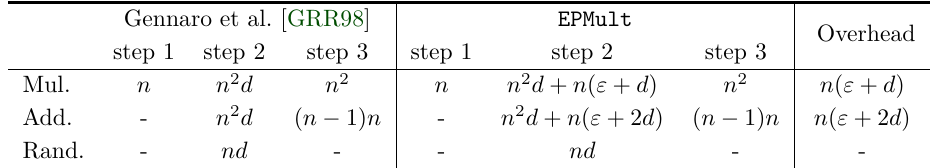
Table 1: Number of operations in Gennaro et al. [GRR98] and EPMult in Section 4.1, where Mul., Add. and Rand. represents the field multiplication, field addition, and randomness requirements